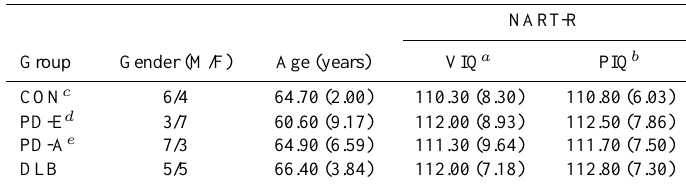
Table 1 Descriptive statistics for age and estimated premorbid